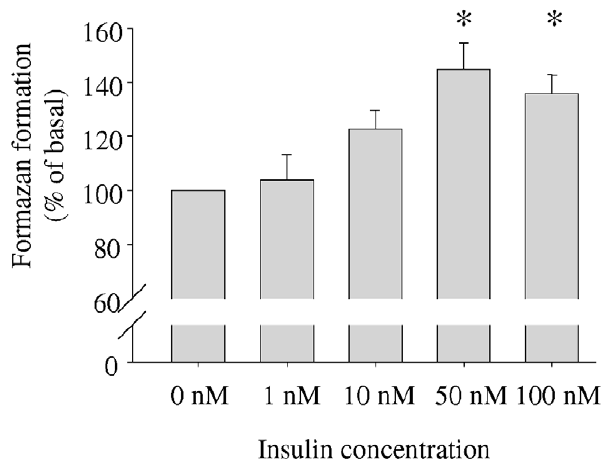
Figure 6. Effects of insulin stimulation on human astrocytes’ proliferation. After starvation for at least 24 hours, cells were treated with the indicated concentrations of insulin for 3 days. Thereafter, cell proliferation was assessed by WST-1 assay. Bars represent means of six independent experiments + SEM. There were significant differences between the groups (ANOVA, p=0.0007). * indicates significant difference from 0 nM (Tukey Kramer post hoc test p , 0.05).